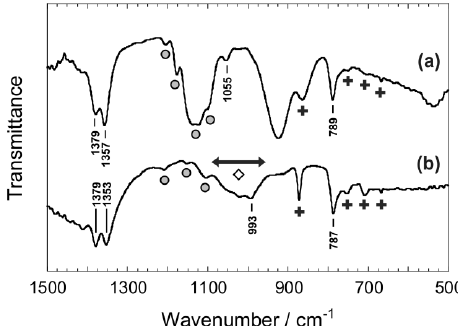
Figure 3. IR spectra for the reaction mixture containing 1 M formaldehyde, 120 mM calcium hydroxide, and 2 mM PBA before ( a ) and after heating at 60 °C for 60 min ( b ). The measurements were carried out after evaporation of the solvent by air blowing on a diamond prism loaded in the ATR attachment. Symbols (cross and circle) denote the absorption bands assignable to calcium hydroxide and formaldehyde,